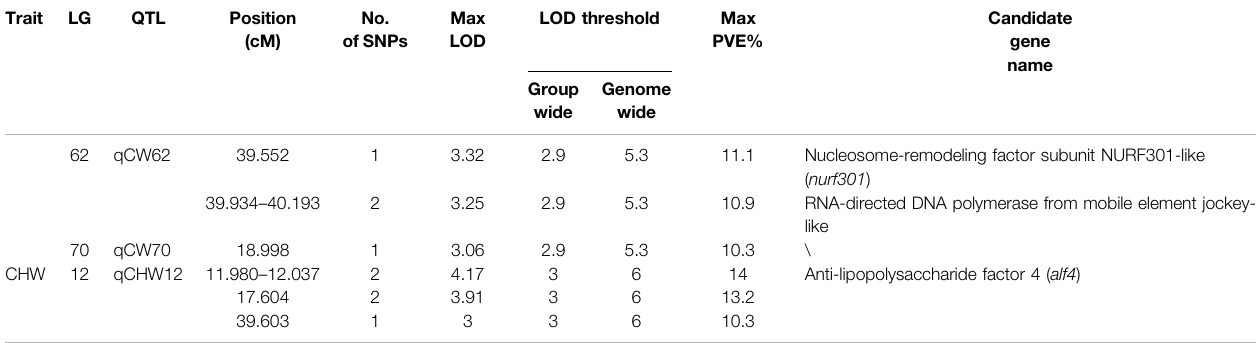
TABLE 3 | ( Continued ) Summary information of growth-related QTL and candidate